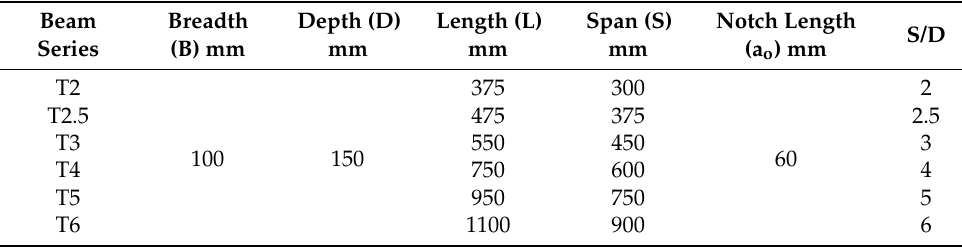
Figure 1. Experimental test loading scheme used. Table 1. Concrete beams